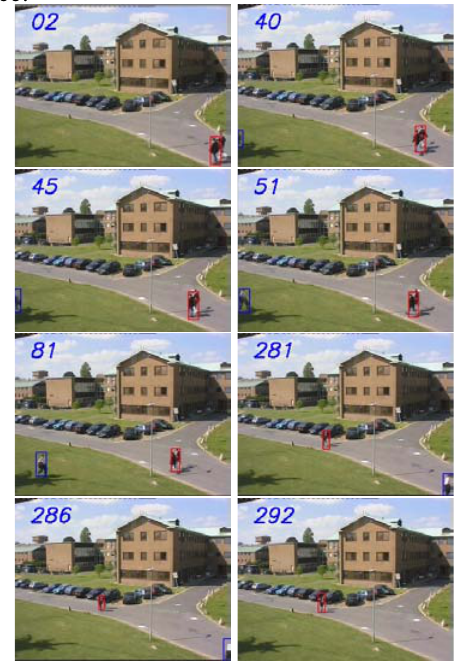
Fig. 7. Object detection results based on